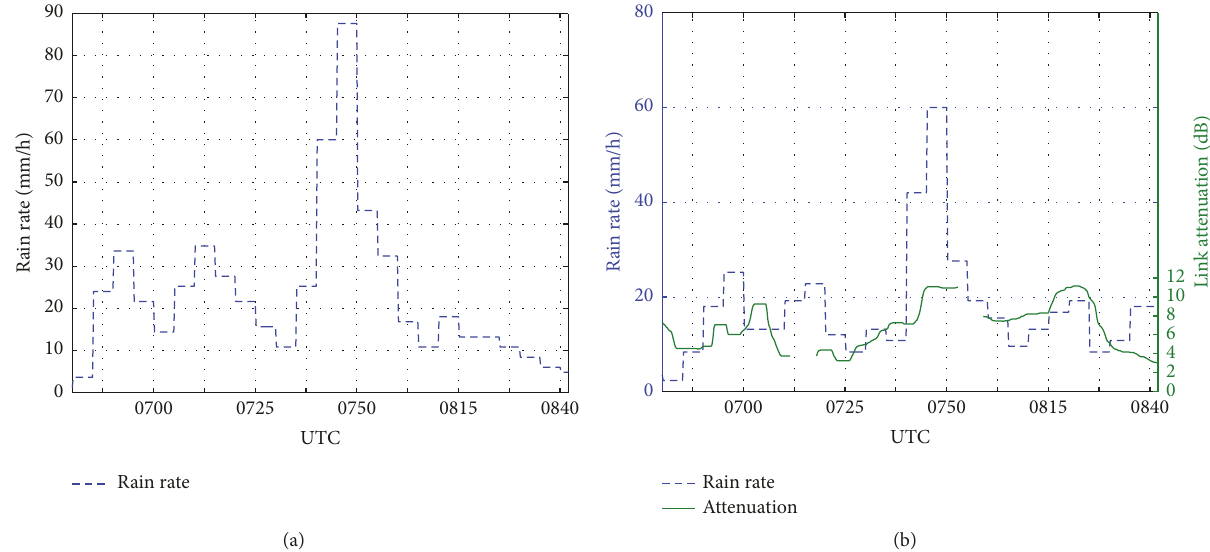
Figure 5: Rain rates measured by (a) gauge 3 and (b) gauge 5 from 0640 to 0842 UTC, 2 June 2015. The link attenuation is also shown in (b).